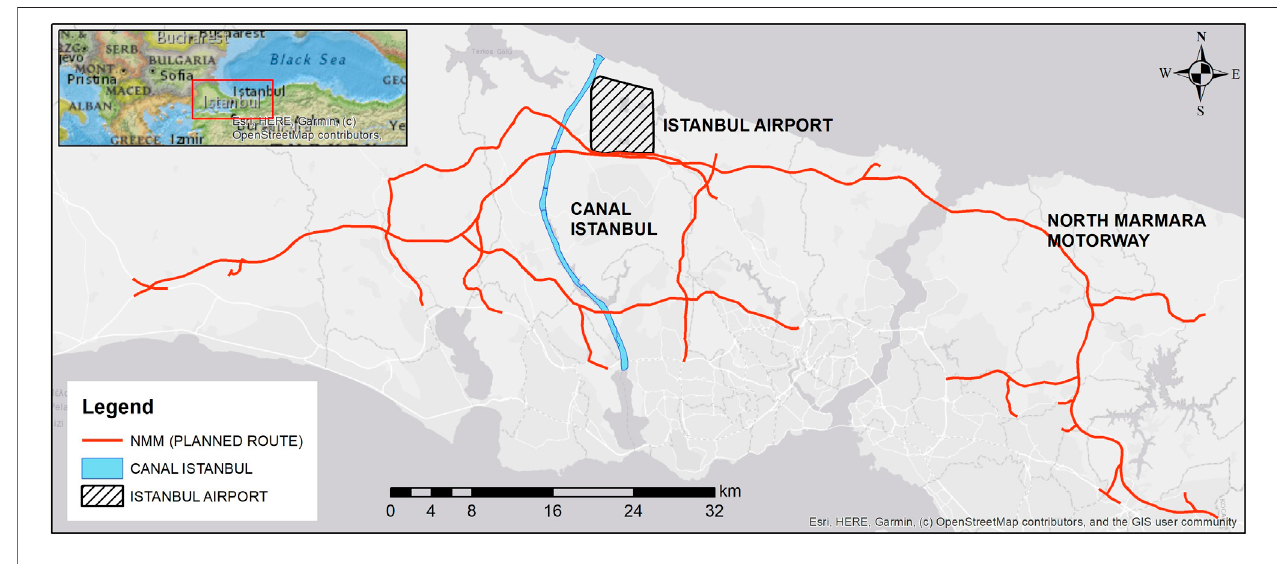
FIGURE 1 | Approximate locations of the projects.